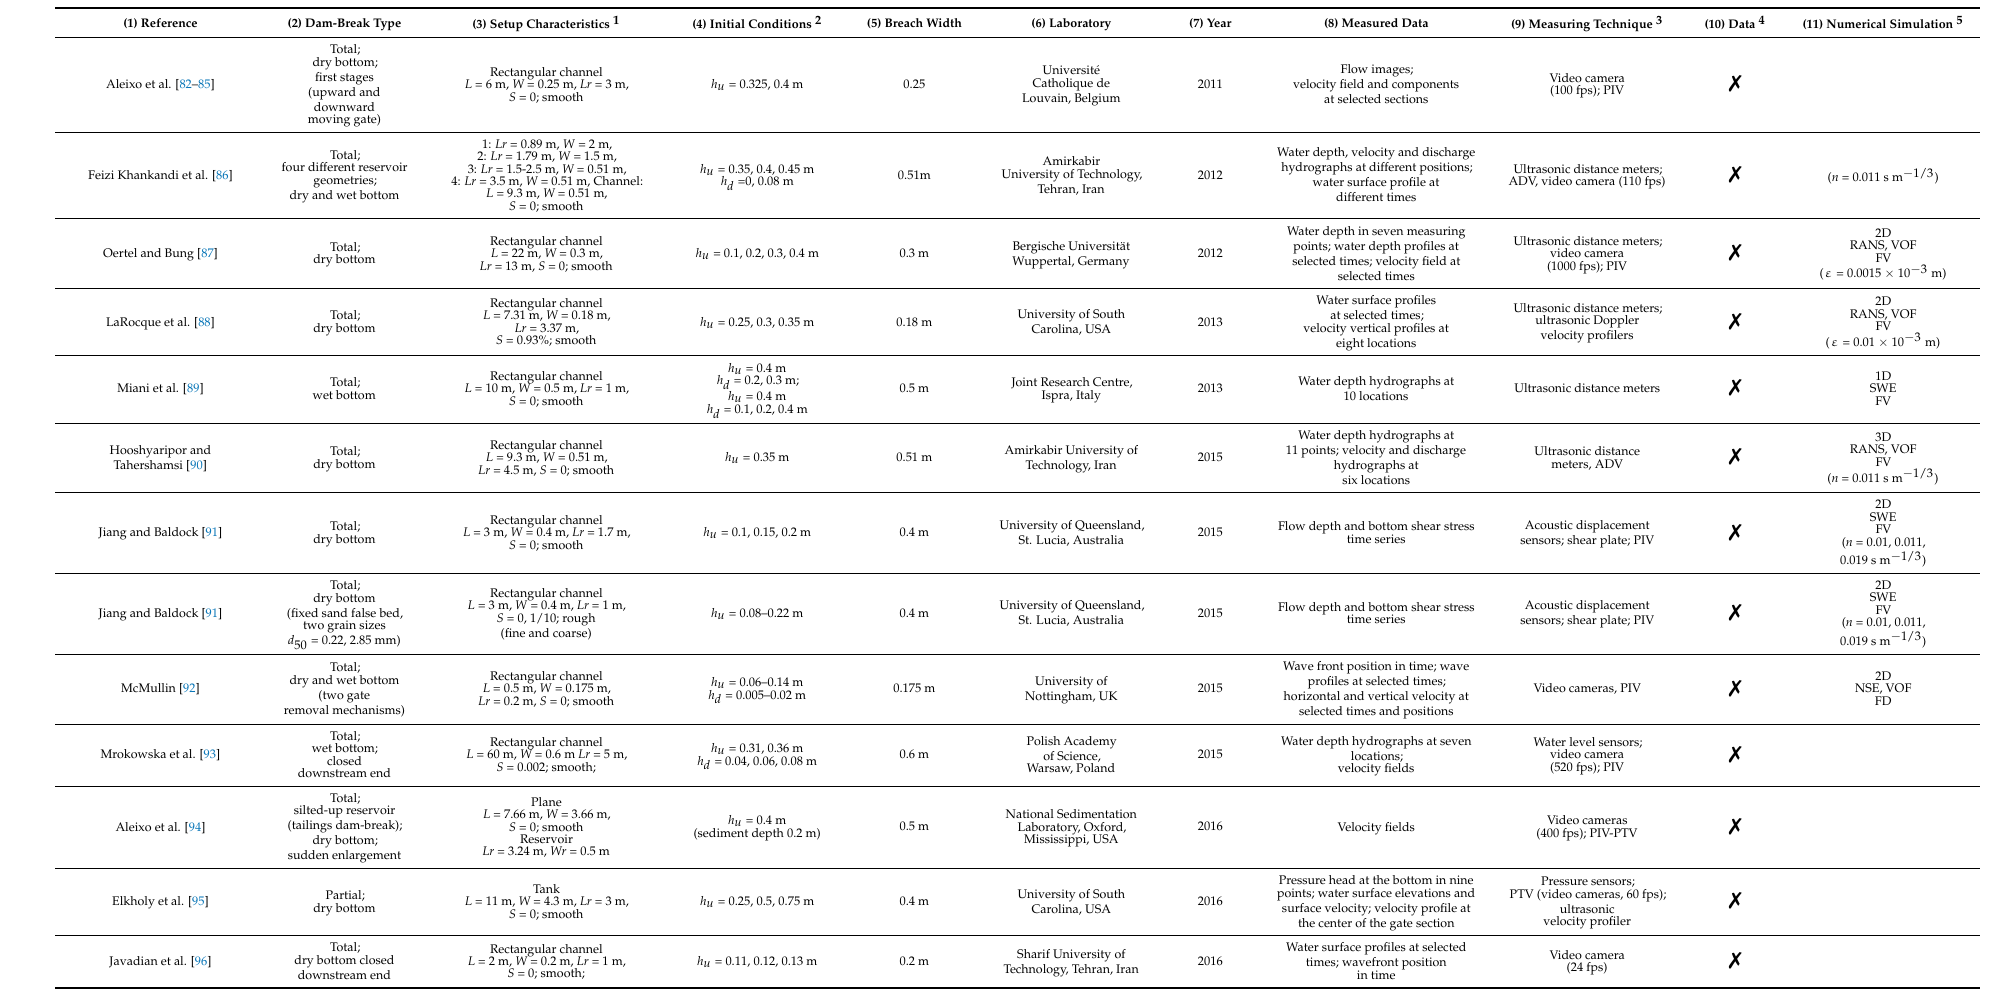
Table 1. Basic experimental investigations of fundamental dam-break wave physical characteristics.